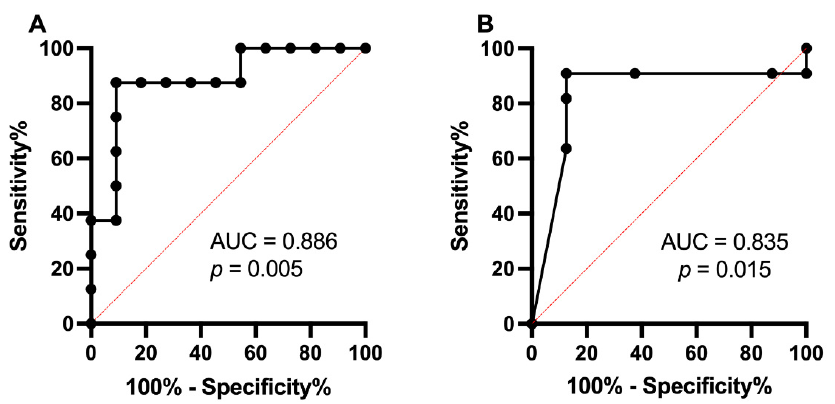
Figure 4. ( A ) Receiver Operating Characteristic Curve (ROC) for miR-200c-3p in type 1 diabetes and healthy controls; ( B ) ROC curve of HbA1c indicating downregulation of miR-200c-3p expression.